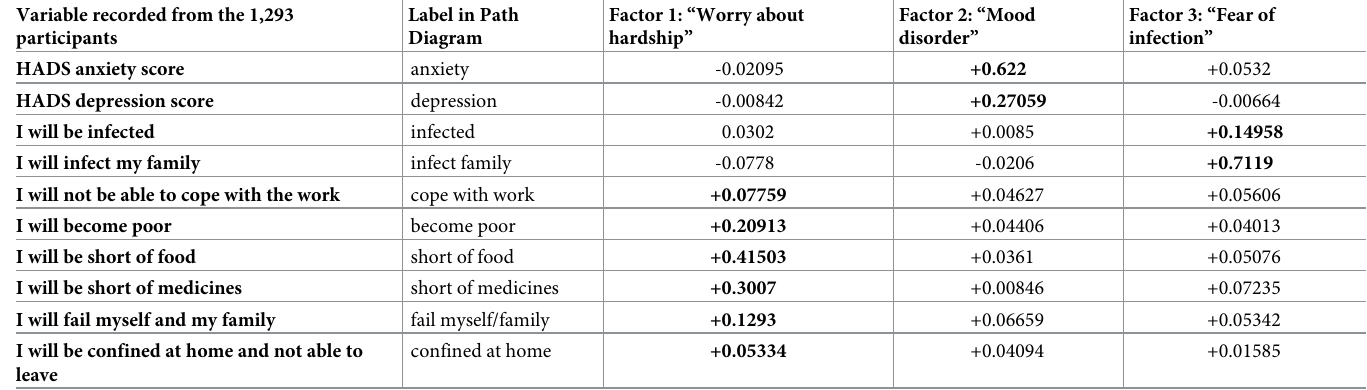
Table 3. Standardized scoring coefficients for the path diagram (Fig 2) of factor analysis of worries and Hospital Anxiety and Depression Scale (HADS) scores: Maximum value per factor is given in bold. Variable recorded from the 1,293